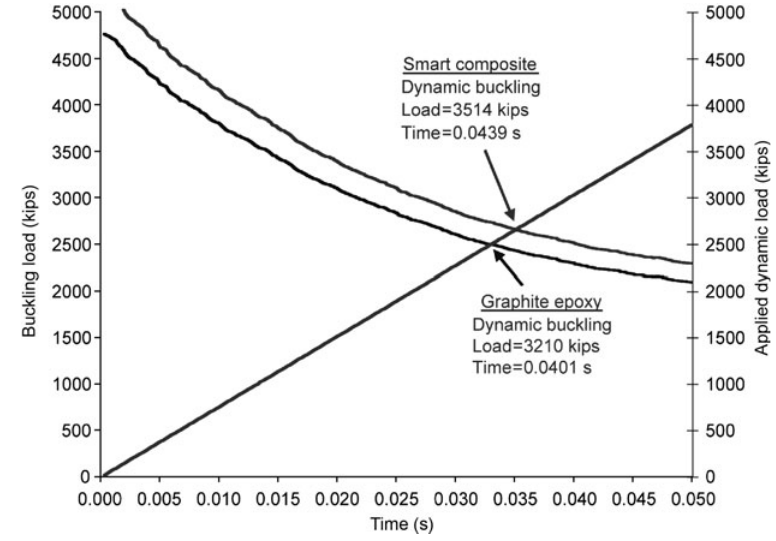
Figure 10 Dynamic buckling load of graphite epoxy and smart composite shells at 0.999 probability. (1 kip = 4.45